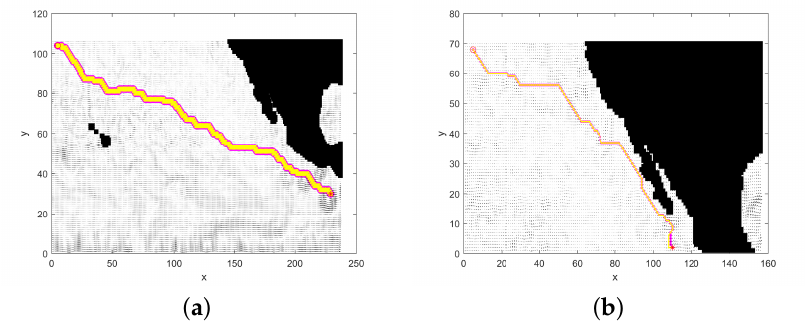
Figure 10. The paths established by two algorithms in the third type of grid maps. ( a ) The paths from (5,104) to (229,30) established by the improved A* algorithm and neural network model in 106 × 237 map. ( b ) The paths from (5,68) to (110,2) established by the improved A* algorithm and neural network model in 70 × 156